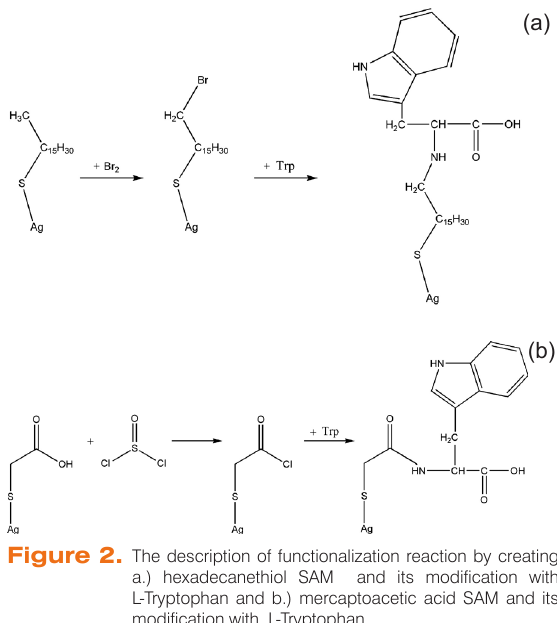
Figure 2. The description of functionalization reaction by creating a.) hexadecanethiol SAM and its modification with L-Tryptophan and b.) mercaptoacetic acid SAM and its modification with L-Tryptophan.